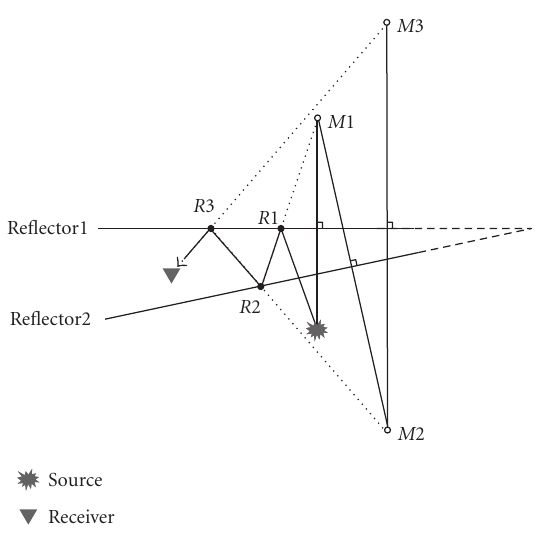
Figure 2: Raypath calculation for multiple reflections.